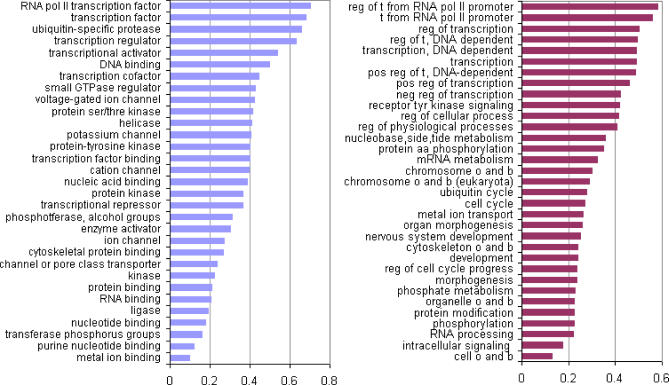
Molecular Function (A) and Biological Process (B) Categories That Are Enriched in Disordered ProteinsCategory names have been abbreviated: regulation (reg), transcription (t), biosynthesis (b), organisation (o), phosphorous (phos), and amino acid (aa). All reported categories are enriched in disordered proteins with p-value < 0.001. The x-axis represents the log odds ratios of observed/expected frequencies of disordered proteins in each GO category from the Fisher test. Higher odds ratios indicate greater enrichment of disordered proteins than expected by chance for the GO category.